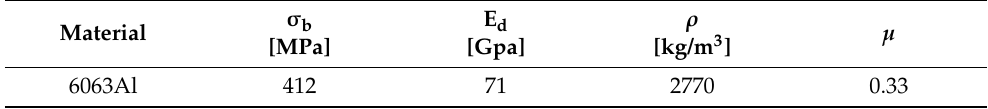
Table 1. Mechanical properties of 6063-aluminum